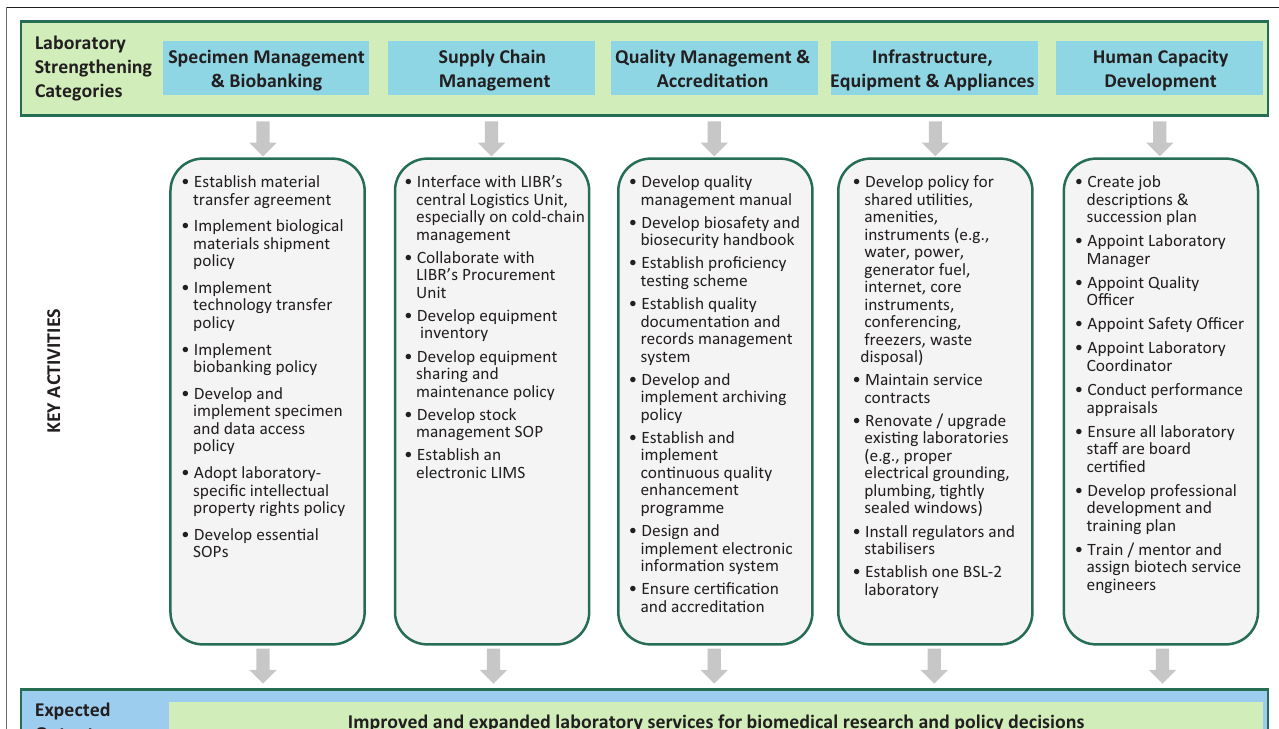
FIGURE 1: Proposed mechanism for strengthening the laboratory system in